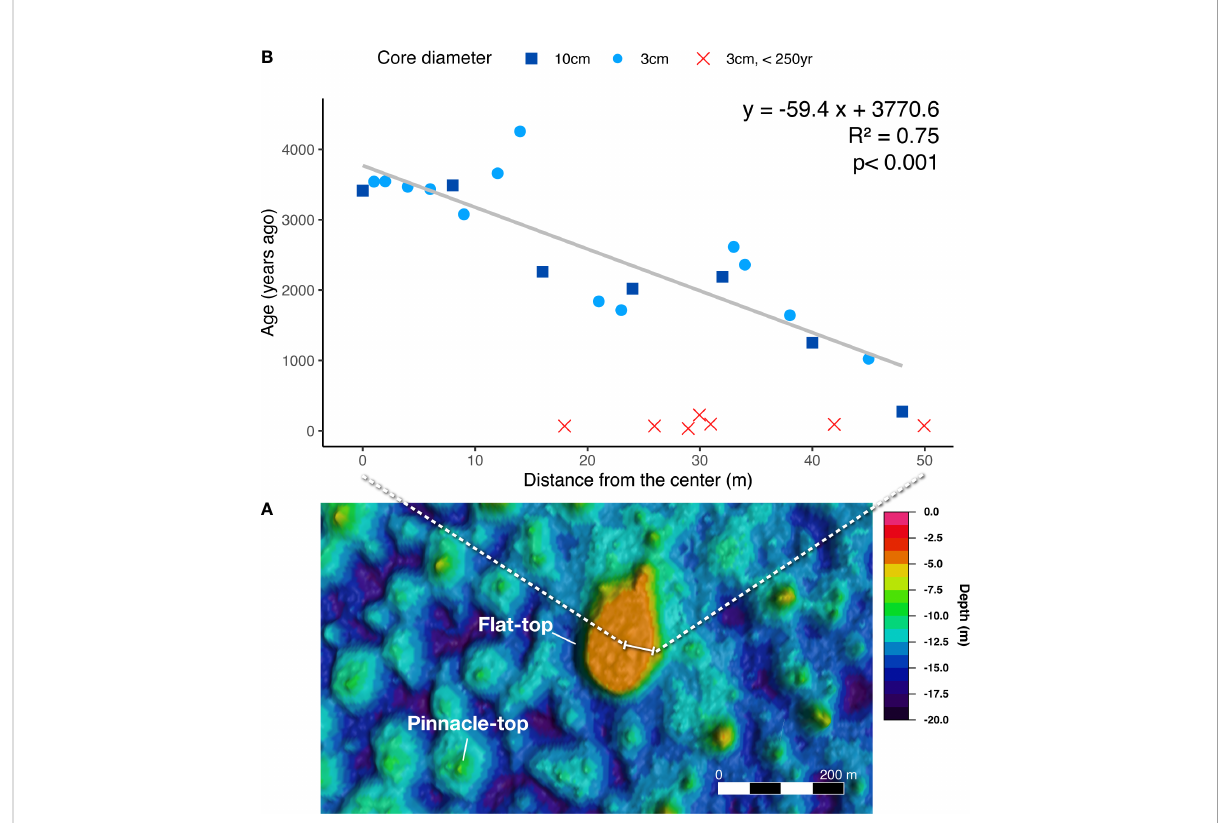
FIGURE 4 Age pattern on fl at top of a patch reef. (A) LiDAR image of the actual sampled fl at-top patch reef (F12) in the Dongsha Atoll lagoon. The top of the patch reef is − 5 m deep, and the diameter of the surface is 100 m. (B) Ages of corals collected from reef surfaces from the center to the periphery of the surface of a patch reef. The linear regression of the blue spots has a slope of 59.4 years/m, equivalent to an average rate of 1.68 cm/year. The red crosses were modern or recent corals attached on the surface and were not included in the regression